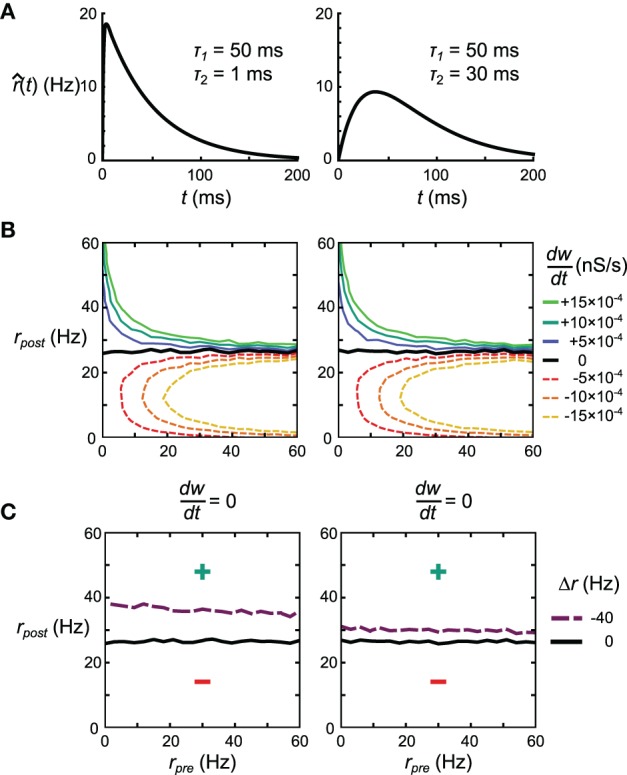
Effect of kernel shape on the behavior of the STDPi plasticity rule. (A) The two kernel shapes that are considered in this figure. The same kernel is used for both pre- and post-synaptic rate estimation. (B)
dwdt as a function of uncorrelated, Poisson distributed pre- and post-synaptic rates for the kernel with τ2 = 1 ms (left) and τ2 = 30 ms (right). (C) The dwdt = 0 nullcline for uncorrelated Poisson distributed pre- and post-synaptic spike trains (black) and negatively correlated, Poisson distributed pre-synaptic and inhomogeneous-Poisson post-synaptic spike trains (purple). The kernels used have τ2 = 1 ms (left) and τ2 = 30 ms (right). All other contour lines have been omitted for clarity.